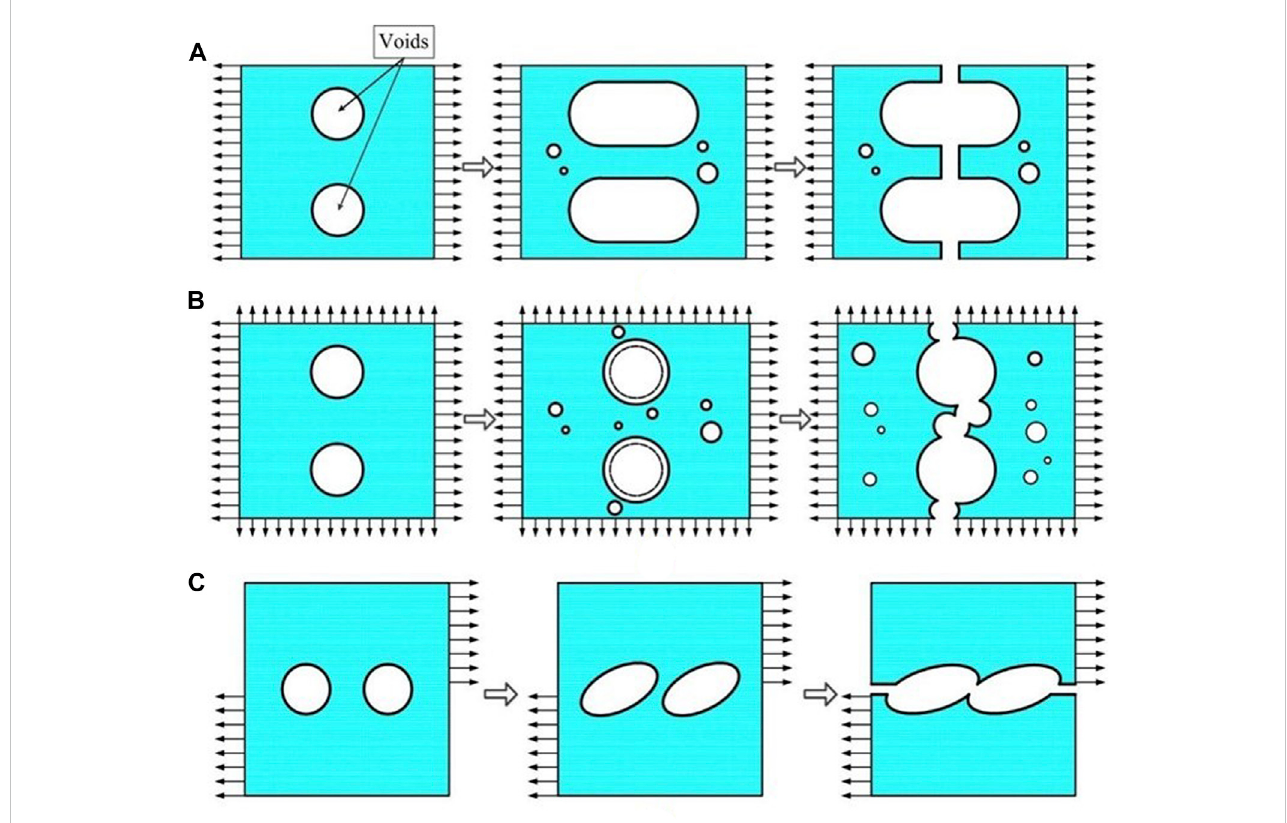
FIGURE 12 Theevolutionofthevoidsunderdiversestressstates: (A) theevolutionofvoidsforSRBspecimens; (B) theevolutionofvoidsforNRBspecimens; (C) :the evolution of voids for Shear-induced